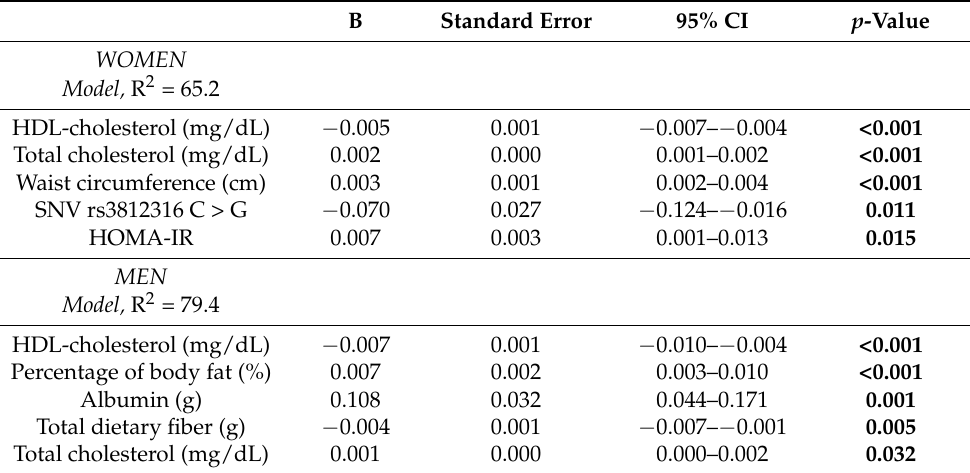
Table 4. Parameters associated with triglyceride levels in women and